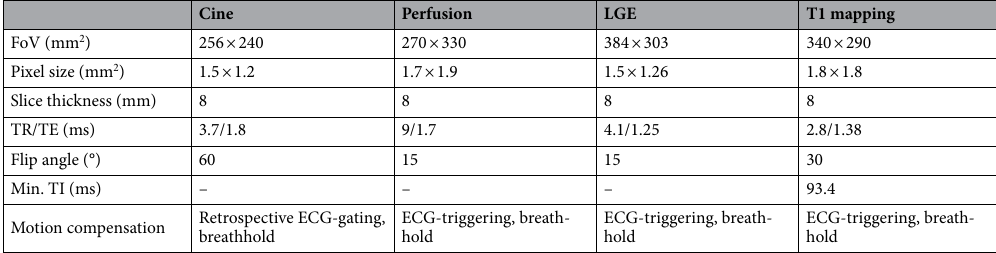
Table 1. CMR imaging parameters in clinical assessment of suspected CAD patients. FoV field of view, TR repetition time, TE echo time, TI inversion time, LGE late-gadolinium